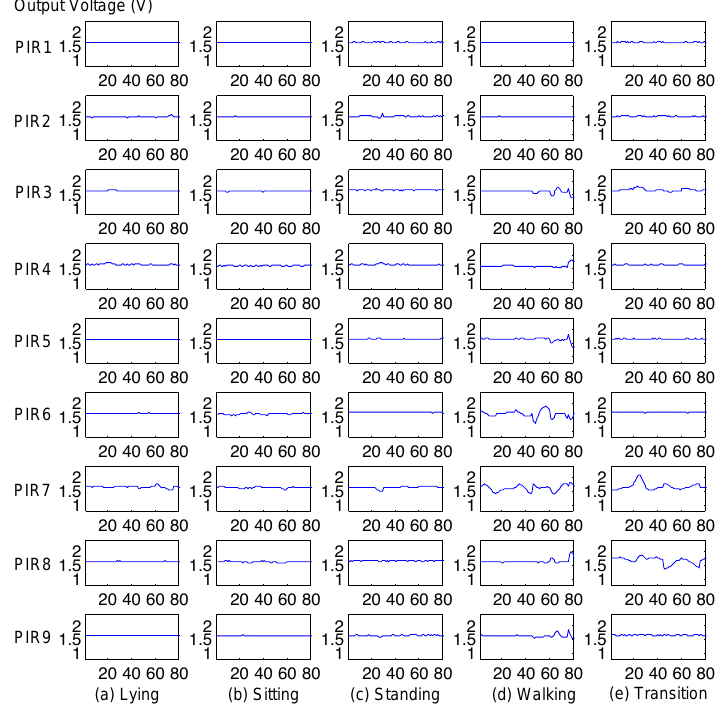
Figure 6. The output voltage of nine PIR sensors in one sensor node for five kinds of activities: ( a ) lying; ( b ) sitting; ( c ) standing; ( d ) walking; and ( e ) transitional